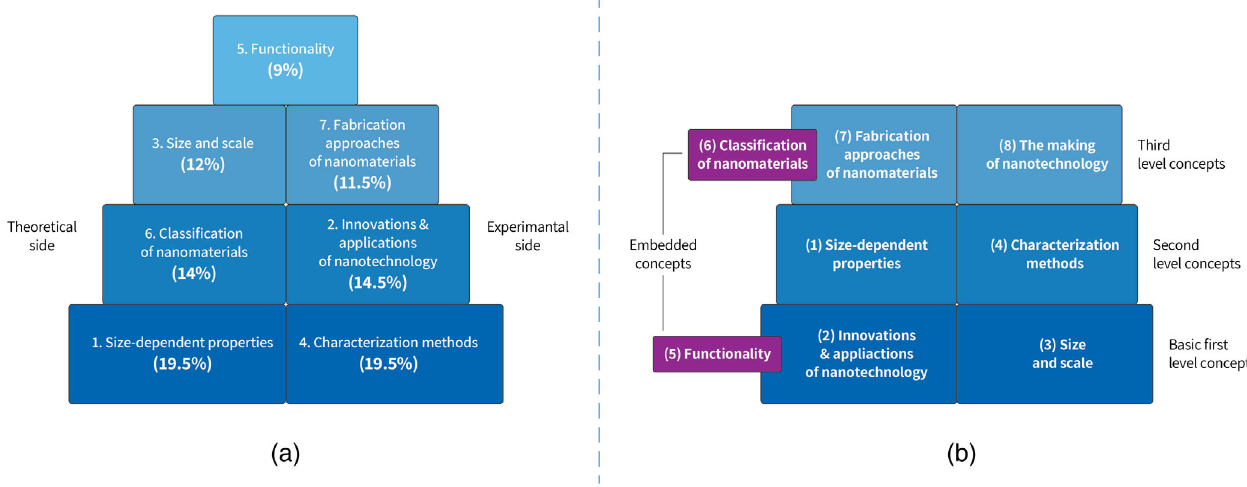
FIG. 6. Comparison of the study results to previous studies according to the hierarchical structures of the 7 NST essential concepts. (A) Constructed by the percent of connections given by the experts in this study (the percent in brackets). It is divided into two sides according to the theoretical, experimental nature of the context given by experts for the connections. (B) Constructed according to a review of NST secondary education literature [22]; this scheme includes an 8th concept that is not used in the current study (the making of nanotechnology).